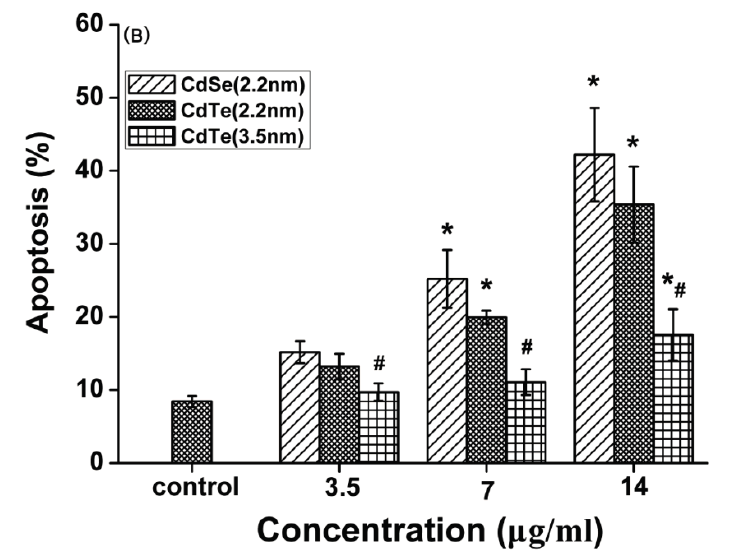
Figure 7. The analysis of the apoptosis in the cells. ( A ) Flow cytometric evaluation of the effect of three types of QDs on L929 mouse fibroblasts apoptosis and necrosis after 24 h of treatment with 3.5, 7, and 14 μ g/mL CdTe QDs. Cells were stained using an apoptotic detection kit (PI/annexin V-FITC). Quadrant (Q)1 shows the percentage of necrotic cells (PI positive cells), Q2 shows the percentage of cells of late apoptotic phase (Double positive cells), Q3 shows the percentage of normal viable cells and Q4 shows the percentage of early apoptotic cells (annexin V-FITC positive cells); ( B ) shows the percentage of apoptosis cell in the early and late stages (Q2+Q4). Data are the mean ± SD of three separate experiments. Significance was indicated by: * p < 0.05 vs. control cells. # p < 0.05 vs. 2.2 m CdTe